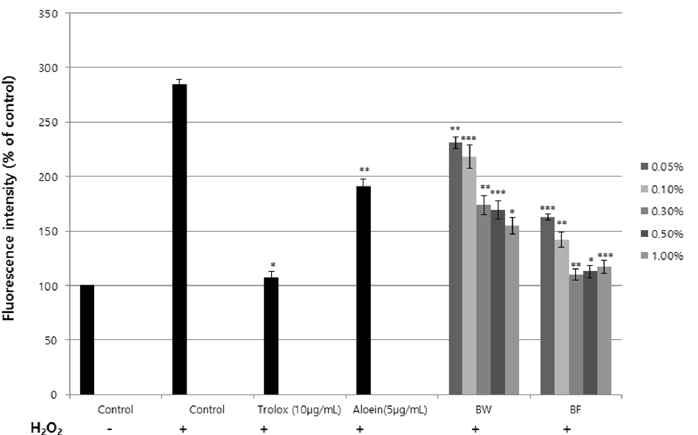
Figure 4. Comparison of intracellular ROS production in H 2 O 2 -treated B16F10 cells in adding various concentrations of two different extracts of aloe skin leaf, and 5 μ g/mL aloesin and 10 μ g/mL Trolox. BW: Water extract of aloe skin leaf at 100 °C for 24 h. BF: Fermented extract of aloe skin leaf fermented with L. plantarum BN41 at 37 °C for 3 days and further extracted by an ultrasound generator at 20 kHz for 4 h. The mean values ± SD for separate triplicate experiments are shown, and error bars indicate the SD. The significance of the difference was set to * p < 0.05, ** p < 0.01 and *** p < 0.001 compared with the control (+).